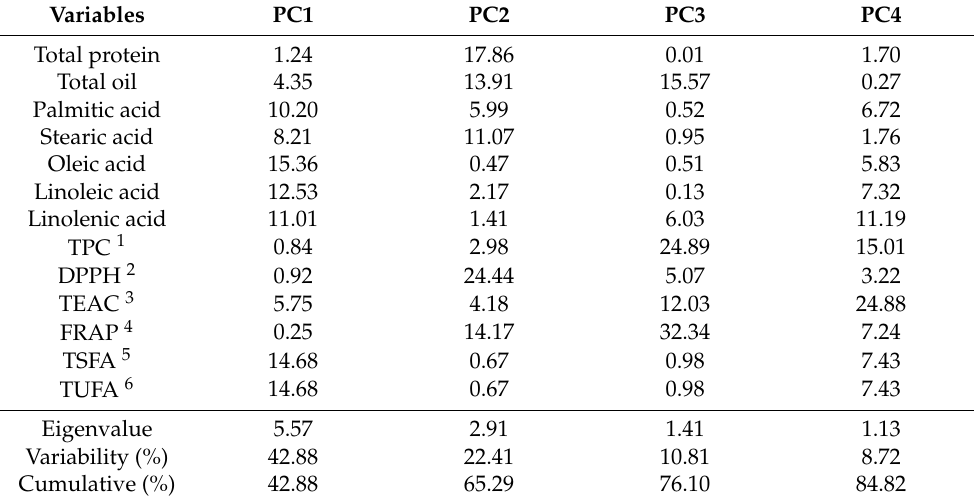
Table 3. Contribution (%) of variables to the first four principal components.